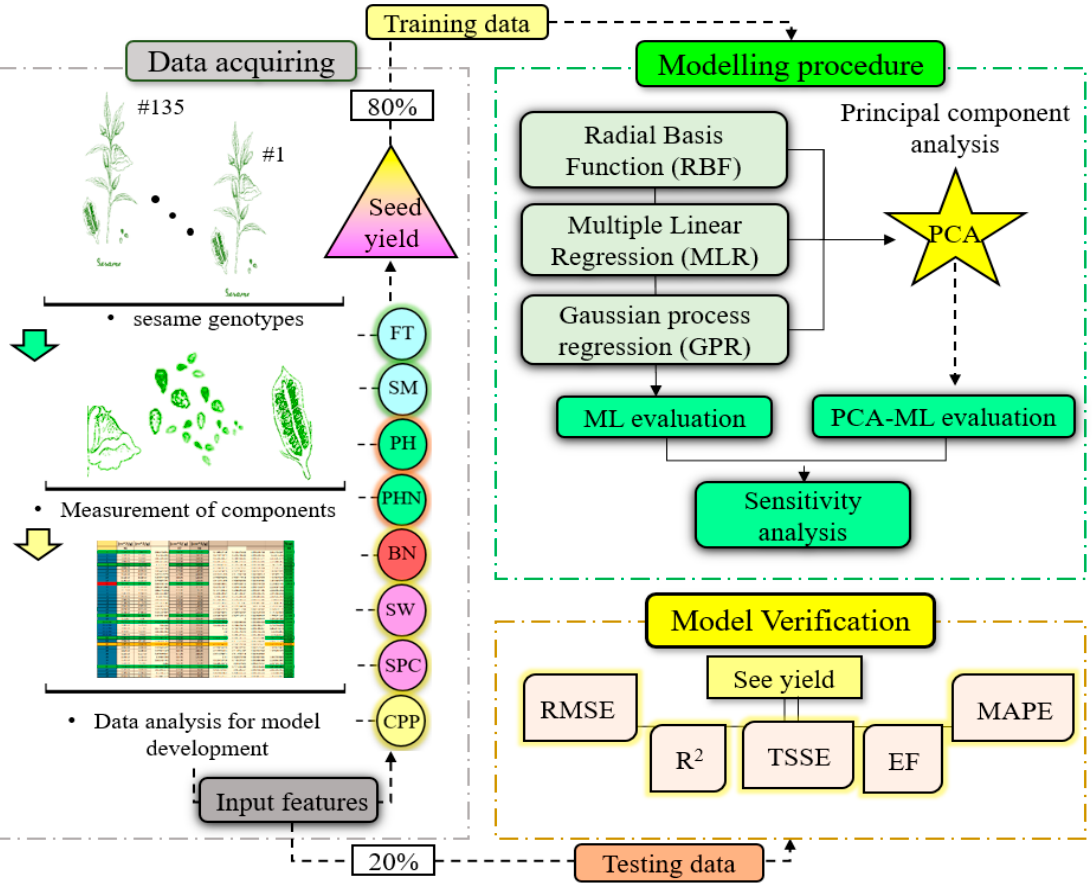
Figure 2. The schematic diagram of the dataset provision, modeling, and model verification processes for the seed yield prediction.